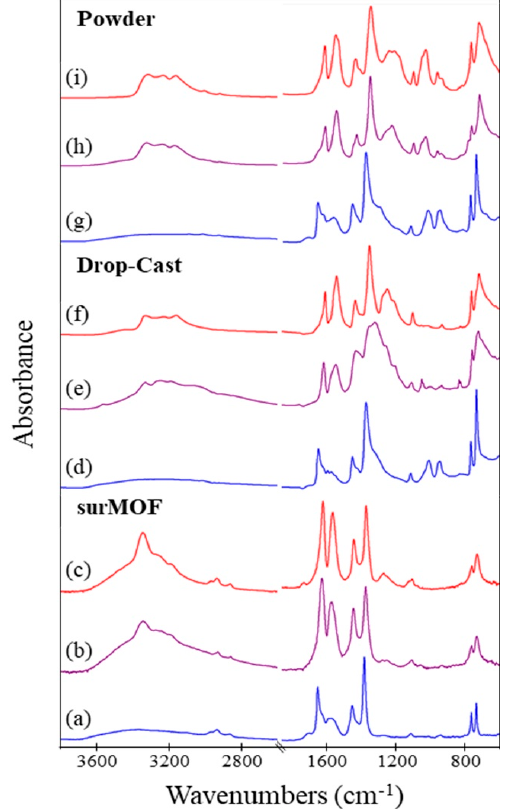
Figure 3. Infrared (IR) spectra of HKUST-1: ( a ) surMOF before exposure to NH 3 ; ( b ) surMOF after exposure without activation; ( c ) surMOF after exposure with prior activation; ( d ) drop-cast thin film before exposure to NH 3 ; ( e ) drop-cast thin film after exposure without activation; ( f ) drop-cast thin film after exposure with prior activation; ( g ) powder before exposure to NH 3 ; ( h ) powder after exposure without activation; and ( i ) powder after exposure with prior activation.